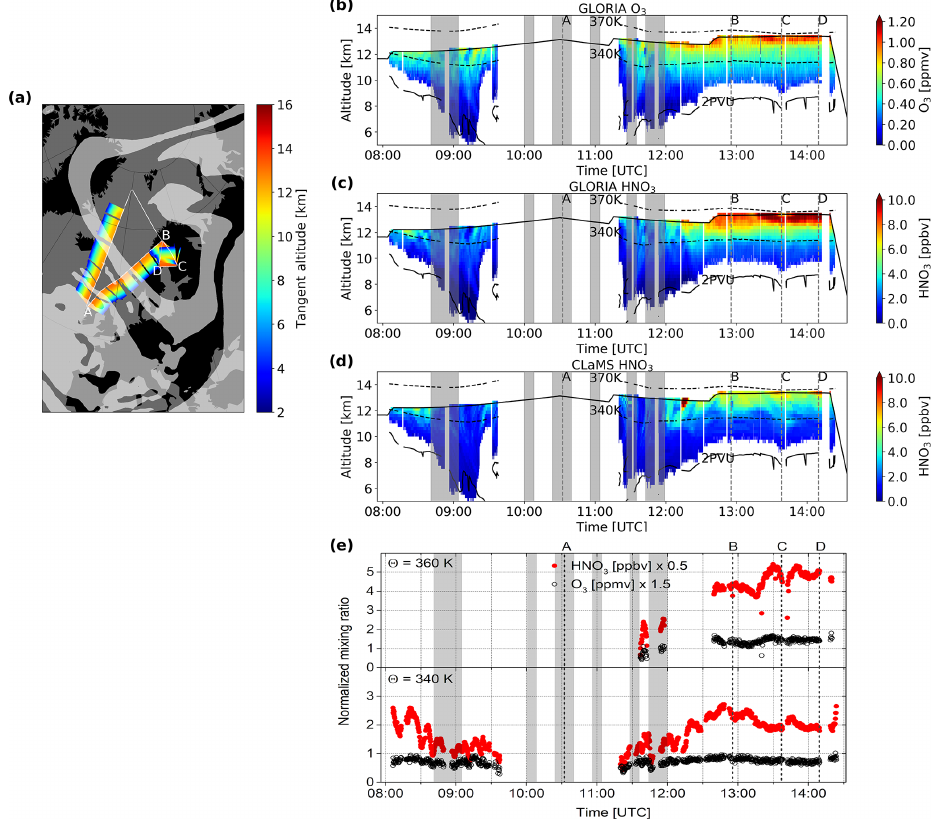
Figure 3. (a) Flight path and vortex filtering according to the Nash criterion at 370K for flight 12 on 31 January 2016. White line: flight track with characteristic waypoints (A, B, C, D); dark grey shading: areas that are associated with the polar vortex. Cross sections of (b) O 3 and (c) HNO 3 distribution derived from GLORIA and (d) HNO 3 distribution simulated by CLaMS. Flight altitude (bold black line), characteristic waypoints (A, B, C, D), 340 and 370K potential temperature levels (MERRA-2, dashed black lines), and 2PVU level (MERRA-2, black line). Please note the changed colour bar for HNO 3 compared to Figs. 2 and 4. (e) Normalized HNO 3 and O 3 mixing ratios along selected isentropes. Passages attributed to non-sub-vortex air are shaded in